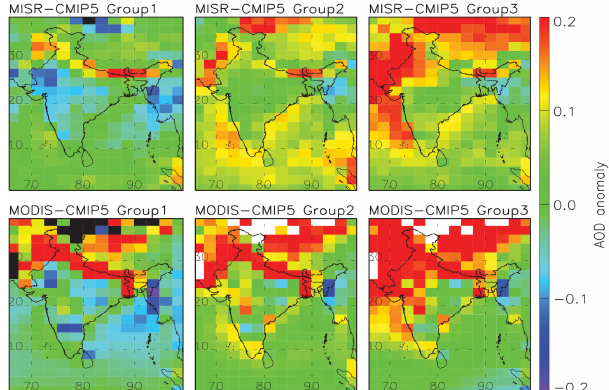
Figure 3. Anomaly in AOD climatology for 2000–2005 from MISR and MODIS, for the three model groups defined in the